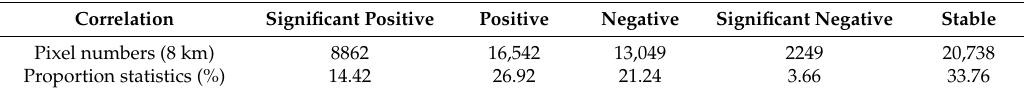
Figure 5. Significant correlation of the accumulated NDVI with log 𝑒 𝑅𝑎𝑖𝑛𝑓𝑎𝑙𝑙 for the growing seasons. Table 1. Statistics of significant correlation between the accumulated NDVI and rainfall.